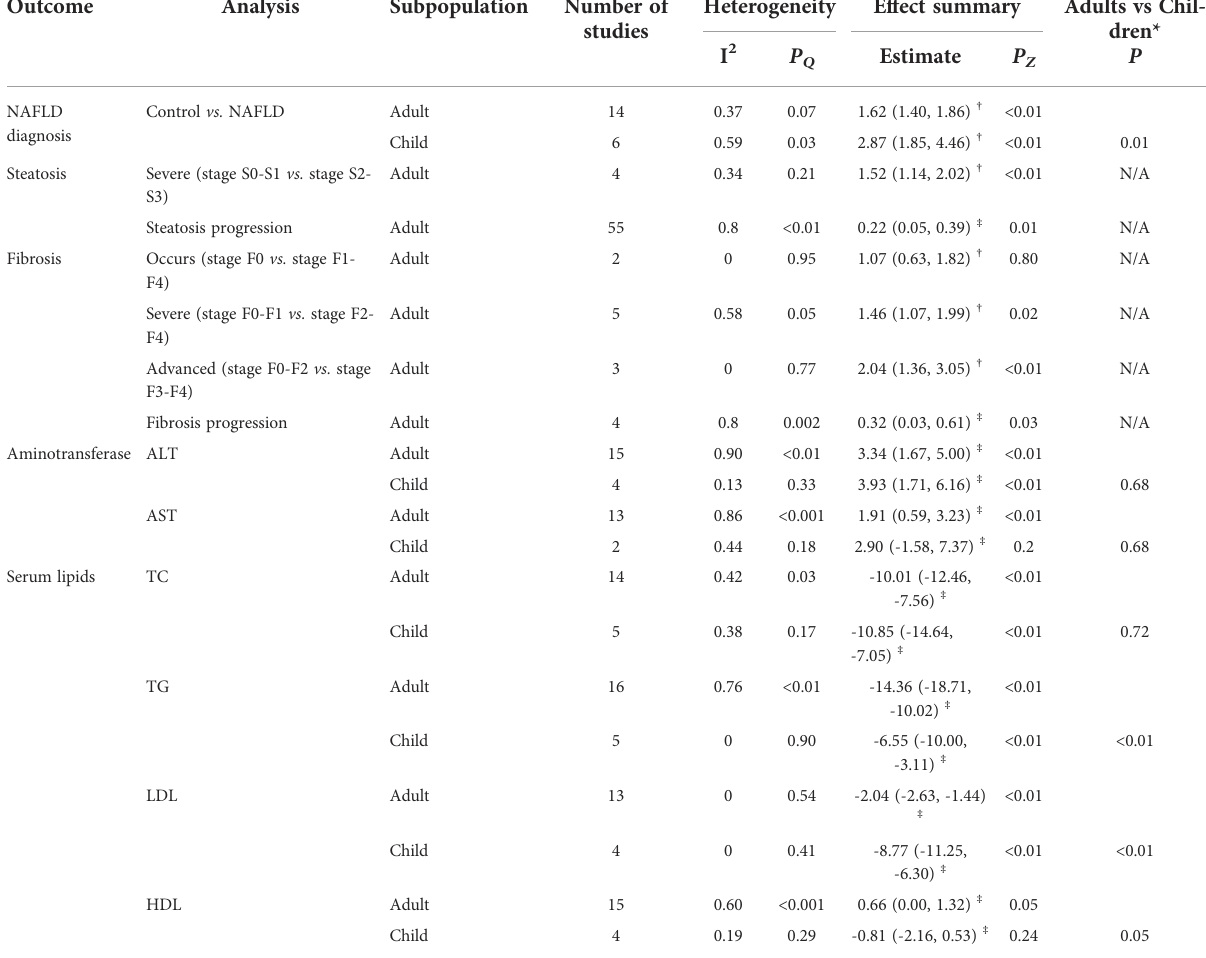
TABLE 1 Summary of results from meta-analysis for adults and